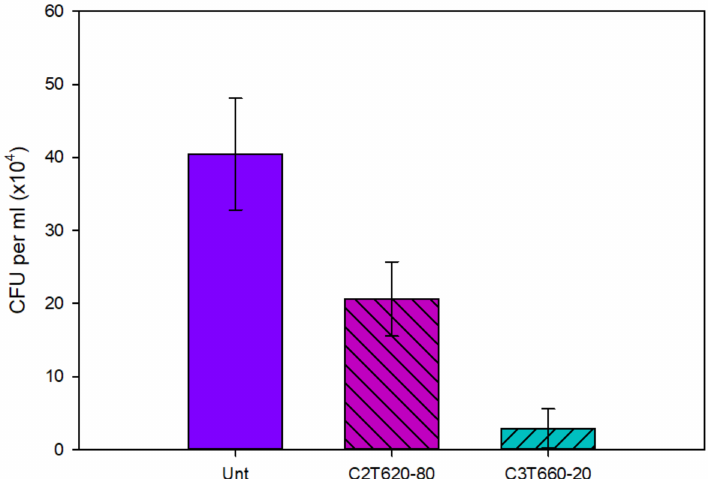
Figure 11. The antibacterial performance of untreated and treated Ti64. Where a smaller number of colony-forming units (CFU) is desirable. Note scale is